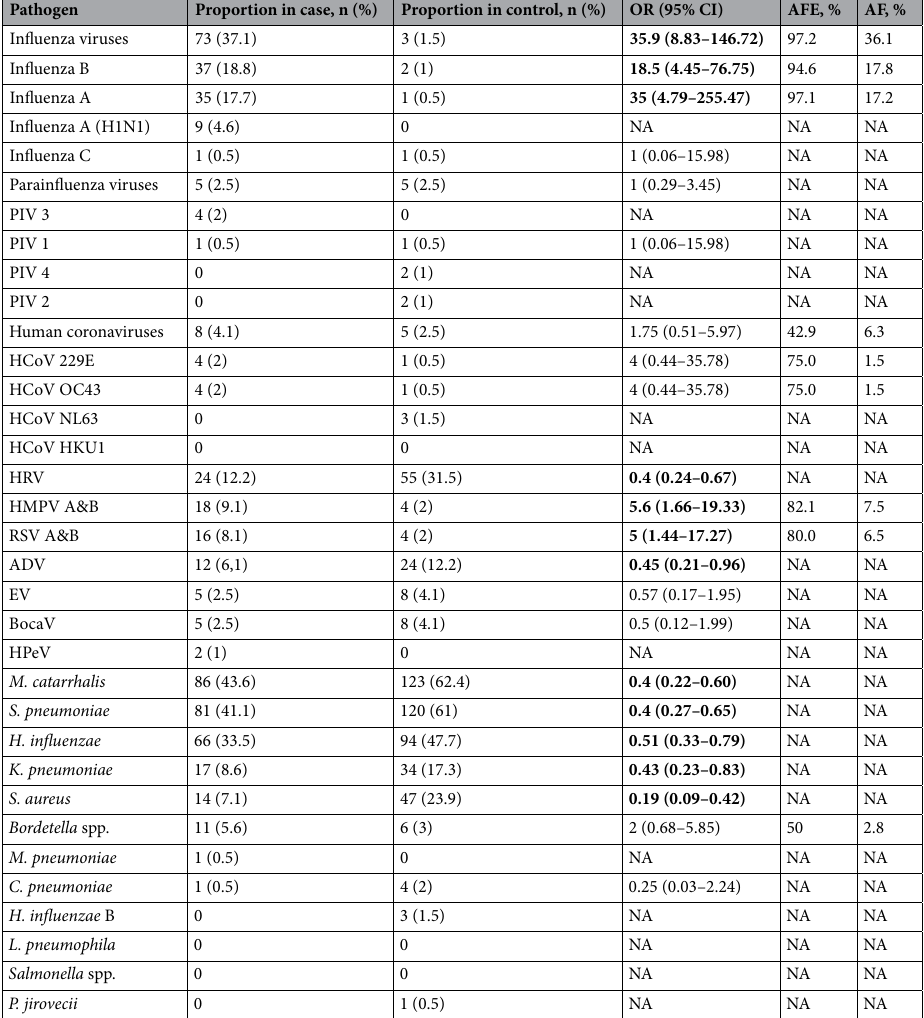
Table 2. Distribution of microorganisms in patients and controls, detected by qRT-PCR in nasopharynx, odds ratio, AFE, and AF. AFE, attributable fraction among the exposed = (1 − 1/OR) * 100; AF, attributable fraction = AFE * Proportion of a given organism in case/100; OR, odds ratio; CI, confident interval; NA, not applicable; HRV, human rhinovirus; HMPV, human metapneumovirus; RSV, respiratory syncytial virus; ADV, adenovirus; EV, enterovirus; BocaV, human bocavirus; HPeV, human parechovirus. Statistically significant OR are written in